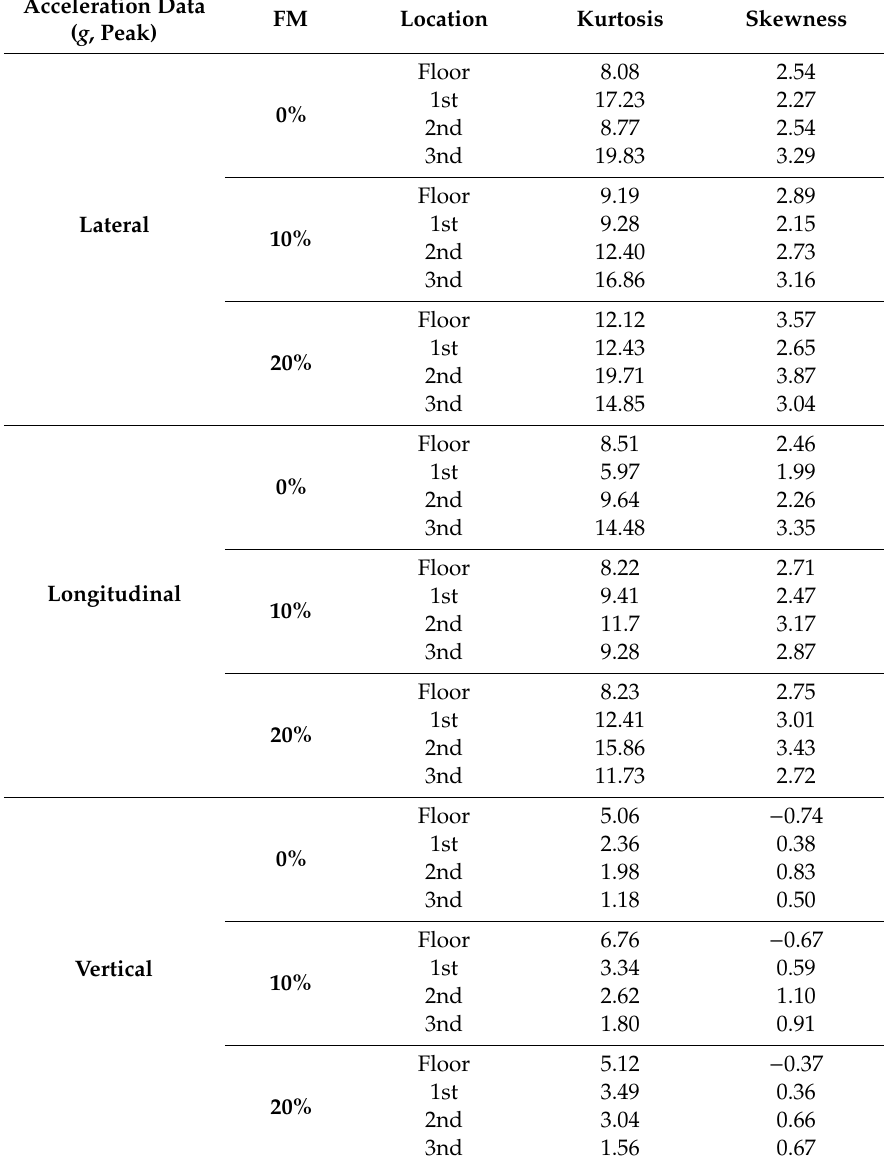
Table A1. Acceleration data for Lateral, Longitudinal and Vertical directions, and statistical data for their